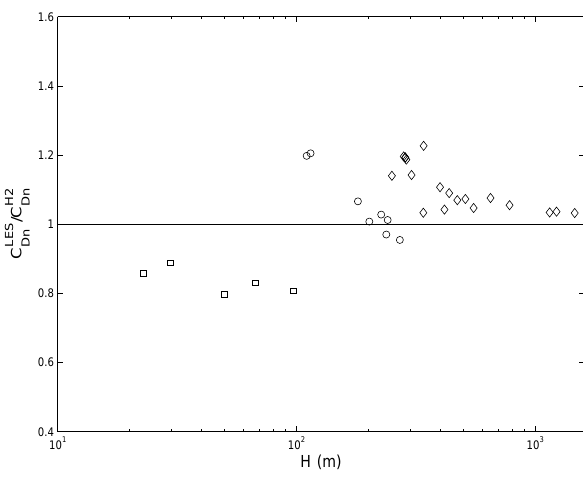
/C H 2 on the PBL depth H . C H 2 Dn Dn